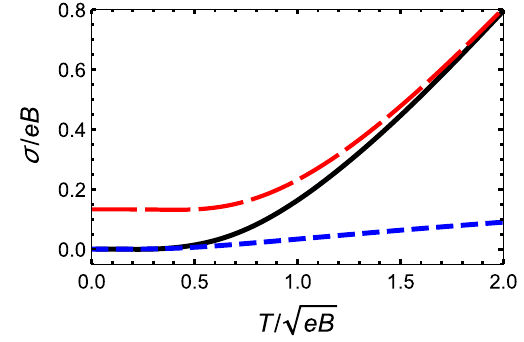
√ √ | eB | η = eB for fixed